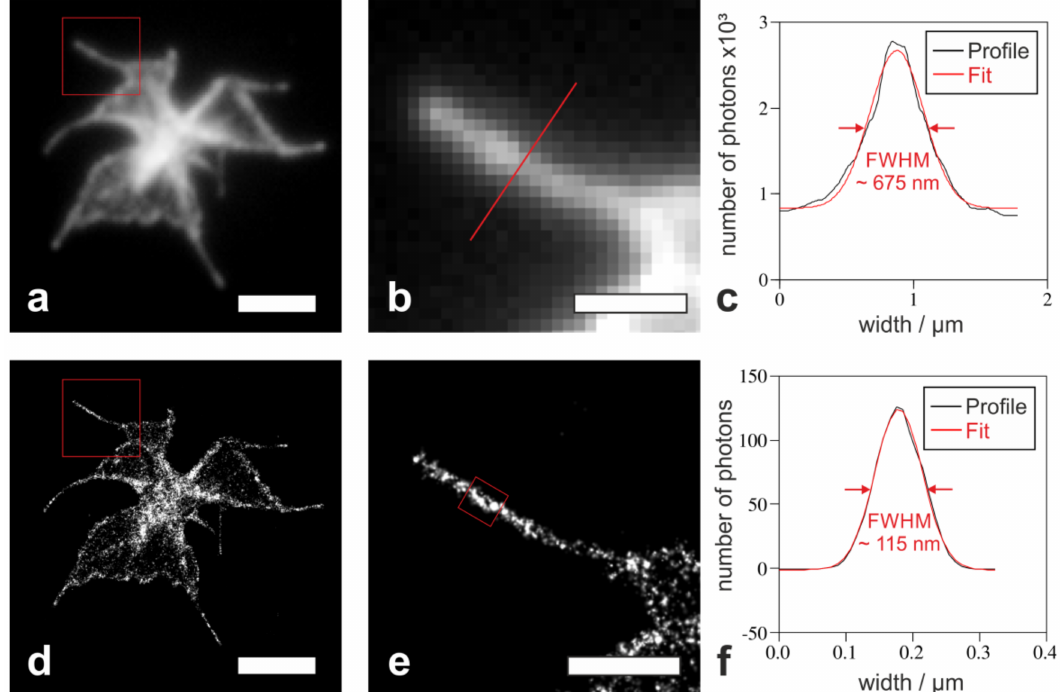
Figure 3. Comparison of a conventional fluorescence and a super-resolution image of the actin cytoskeleton of a platelet with a spindle-like morphology labeled with Phalloidin Alexa 647 ( a , d ). Close-up of the region of interest from the image in ( a , d ) shows a single filopodium ( b , e ). The intensity profile of the filopodium cross section from the boxed region ( b , e ) has been fitted with a Gaussian function ( c , f ). From the fit a FWHM of 675 nm ( c ) or of 115 nm ( f ) has been determined for the filopodium width. Scale bar for ( a , d ) 3 µ m and for ( b , e ) 1 µ